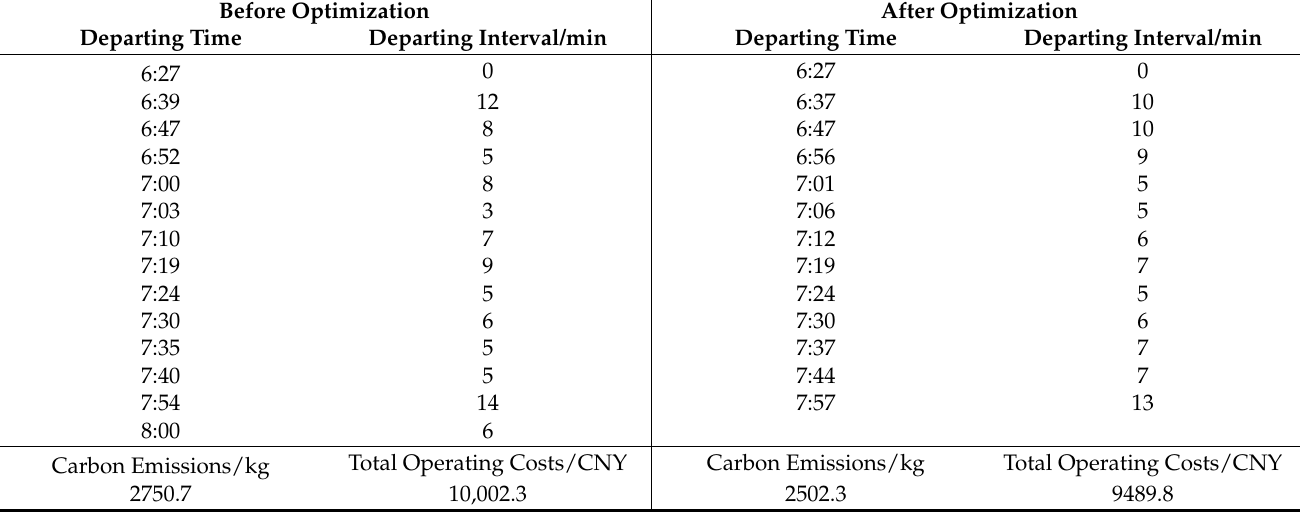
Table 2. Comparison before and after